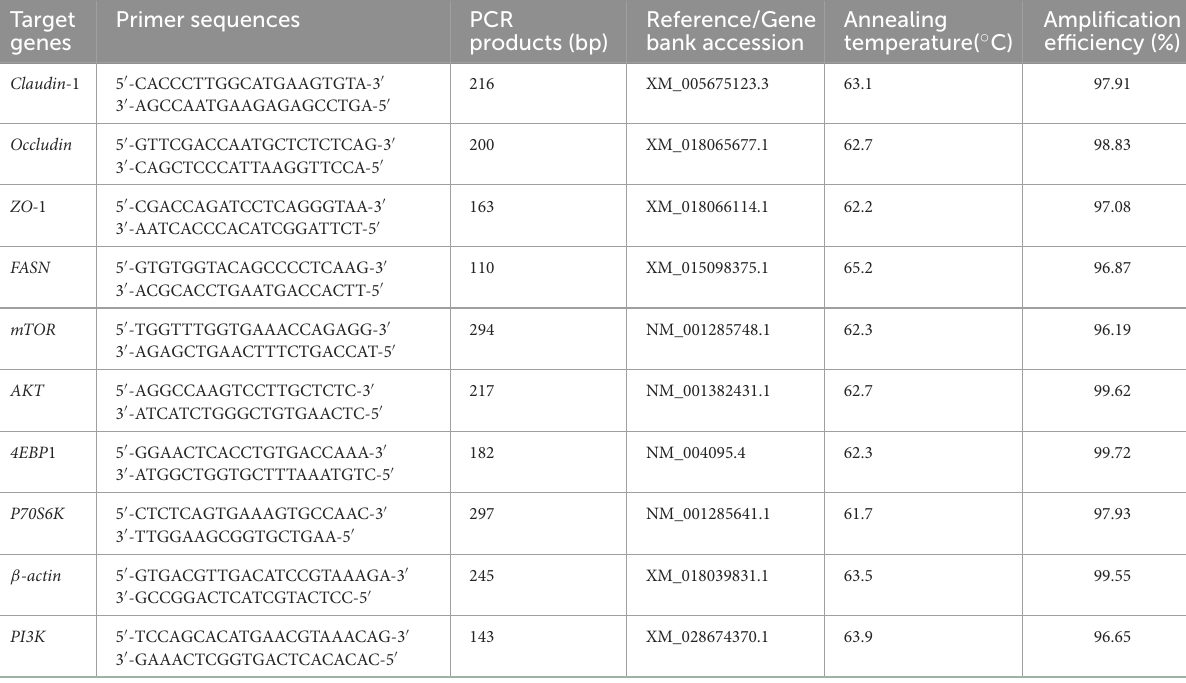
TABLE 2 Primer sequences of target genes used for